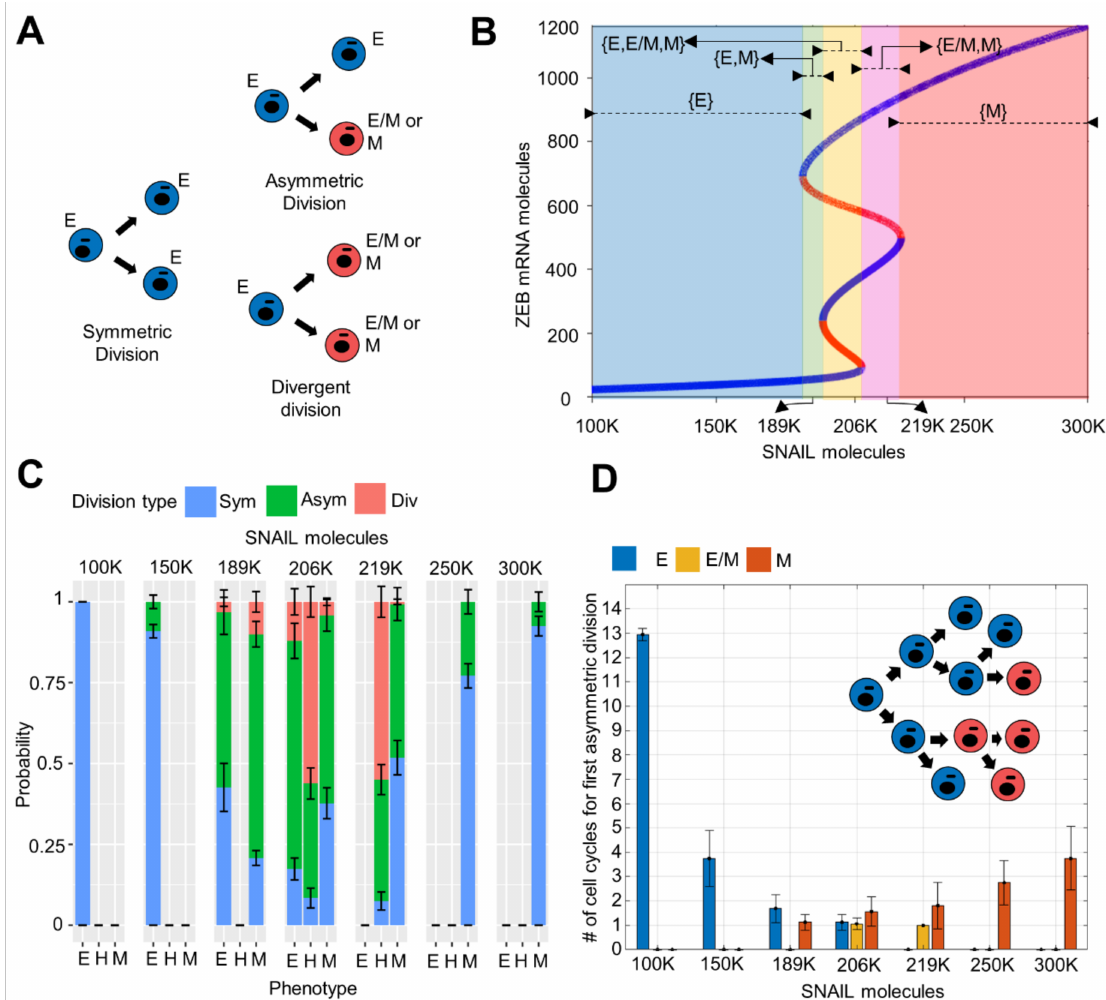
Figure 4. Phenotypic switching probability and its rate at cell division depends on the location of a cell on E-M axis. (A ) Schematic of different possible cell division types. ( B ) Different ranges of SNAIL where E, E/M, and M phenotypes are stable. ( C ) Probabilities of an E, E/M or M cell to undergo one among the three division types ( A ) when its SNAIL levels lie in different regions in bifurcation diagram ( B ). ( D ) Number of cell cycles (generations) required to make first asymmetric or divergent division when a parent E, E/M or M cells’ SNAIL level lied in different regions in bifurcation diagram ( B ) (schematic given in inset). Mean and standard deviation was calculated from 10 and 16 independent runs in ( C , D ), respectively. In ( C ), each run includes 100 iterations. η 1 = 0.2, η 2 =